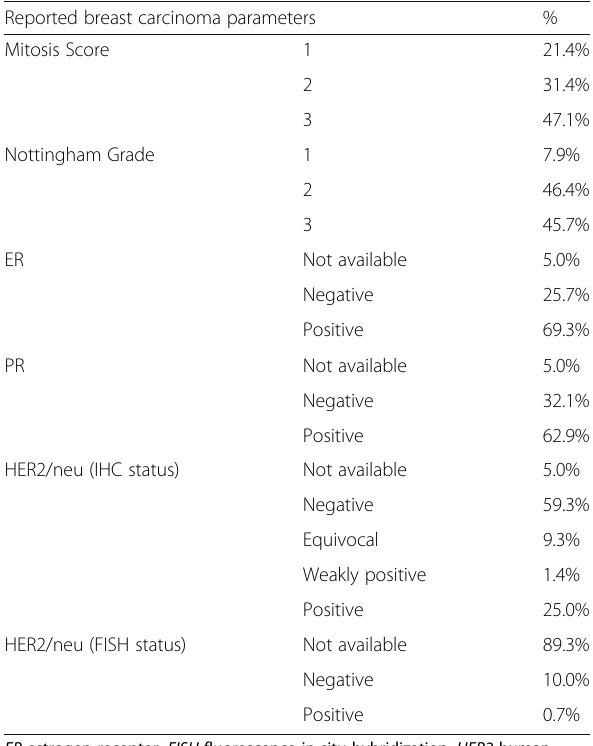
Table 1 Profile of invasive ductal carcinoma cases enrolled in the